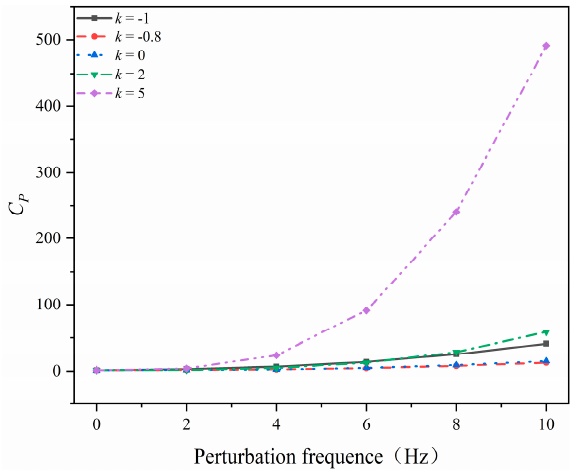
Figure 6. Variation of input power coefficient.